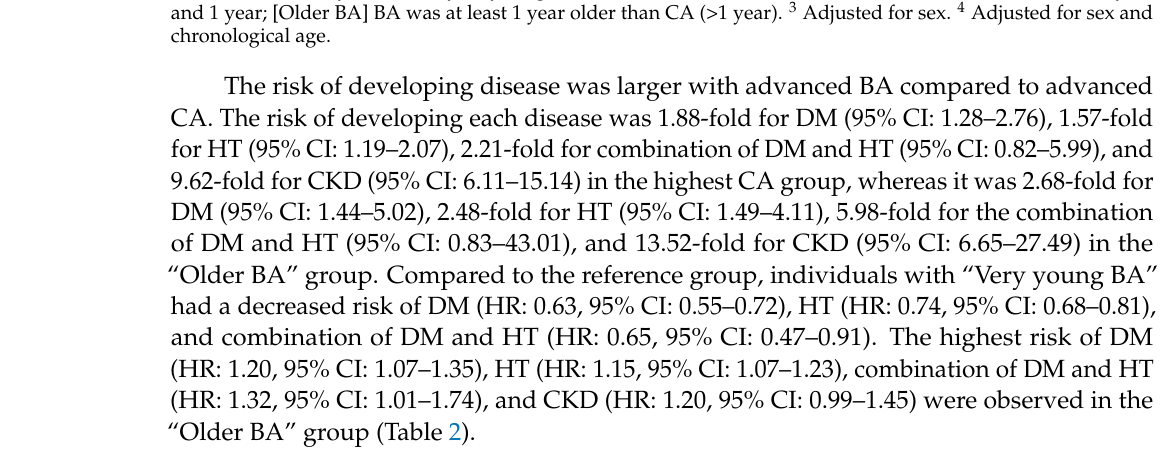
Table 2. Association with CA, BA, and Age-Diff on the risk of the development of DM, HT, combina- tion of DM and HT, and CKD over total follow-up periods (median 6 years, range 2–13 years) among 101,980 cohort participants in the